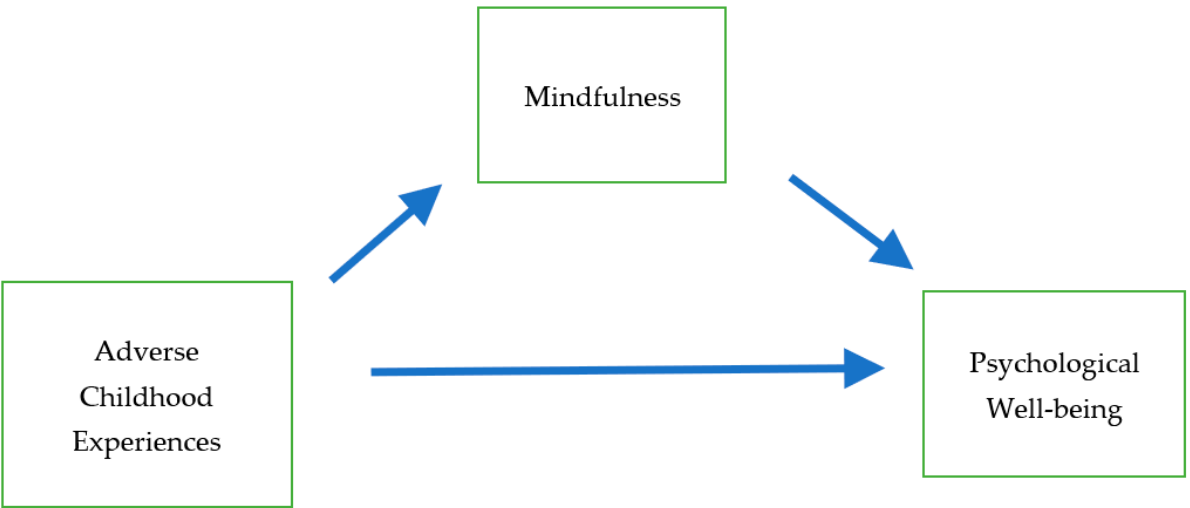
Figure 1. Conceptual model of adverse childhood experiences, mindfulness, and psychological well-being. Hypothesis 1 (H1). ACEs are negatively associated with mindfulness in Chinese college